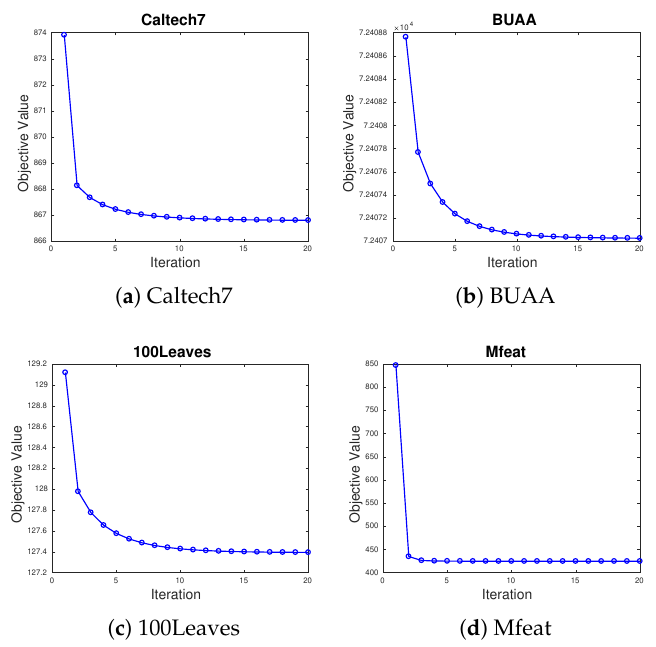
Figure 6. The convergence curves of the objective values on four